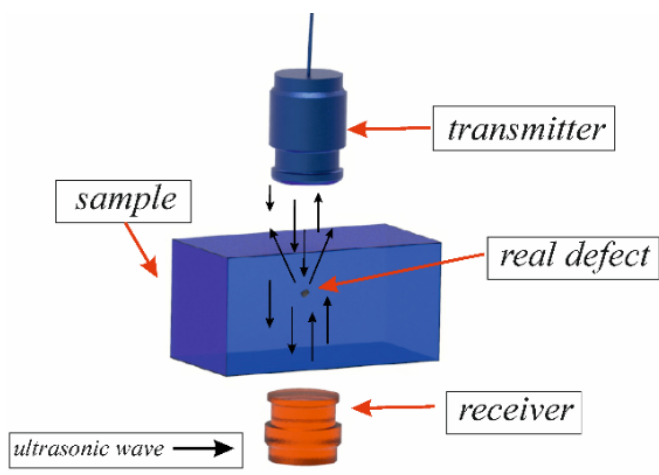
Figure 1. Schematic design of through-transmission method.